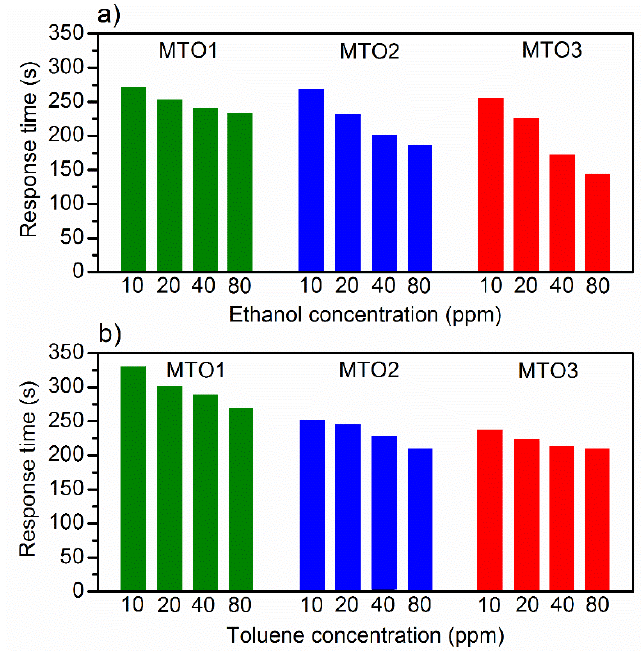
Figure 12. Response time to various concentrations of ( a ) ethanol, and ( b ) toluene.